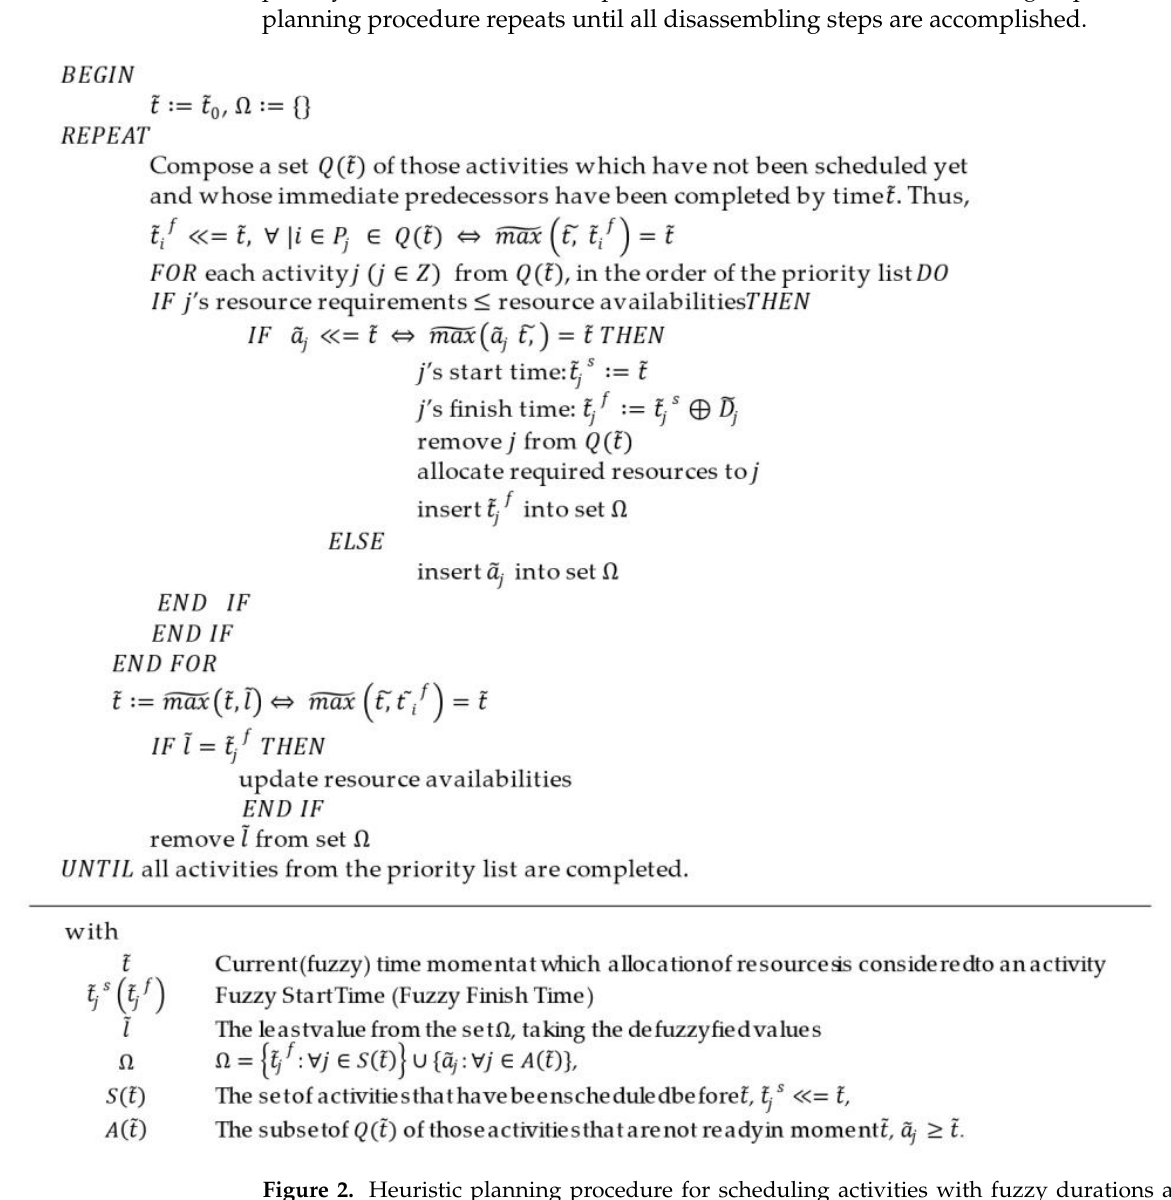
Figure 2. Heuristic planning procedure for scheduling activities with fuzzy durations adapted from [26,43,44].